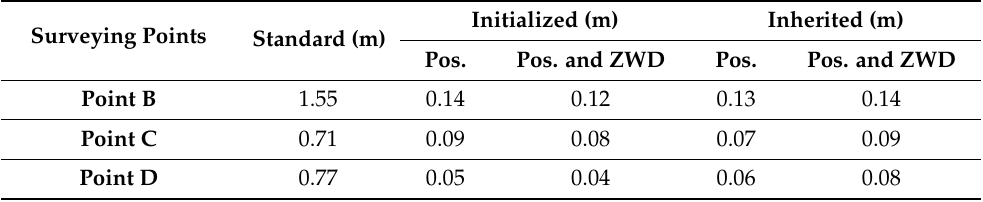
Table 3. RMSE of PPP bridge displacements at surveying points B, C and